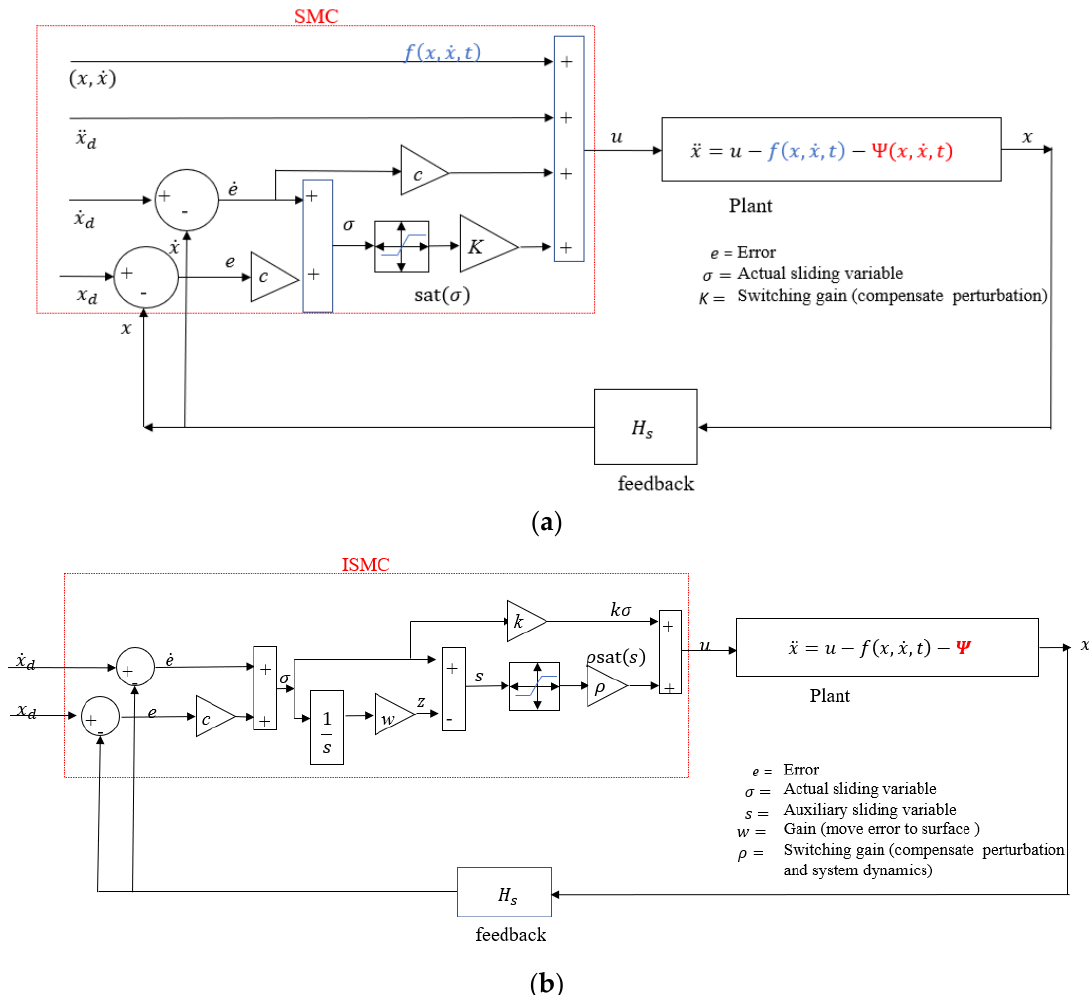
Figure 4. Detailed block diagram of proposed control algorithms: ( a ) SMC, ( b ) ISMC.